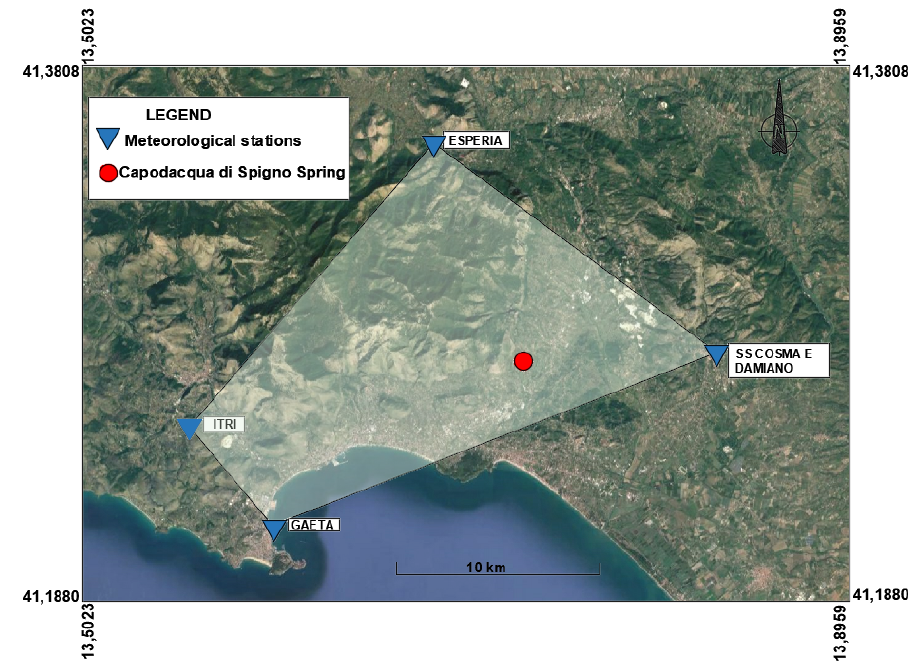
Figure 4. Thermo-pluviometric stations of the study area (latitude and longitude are in decimal de- grees).